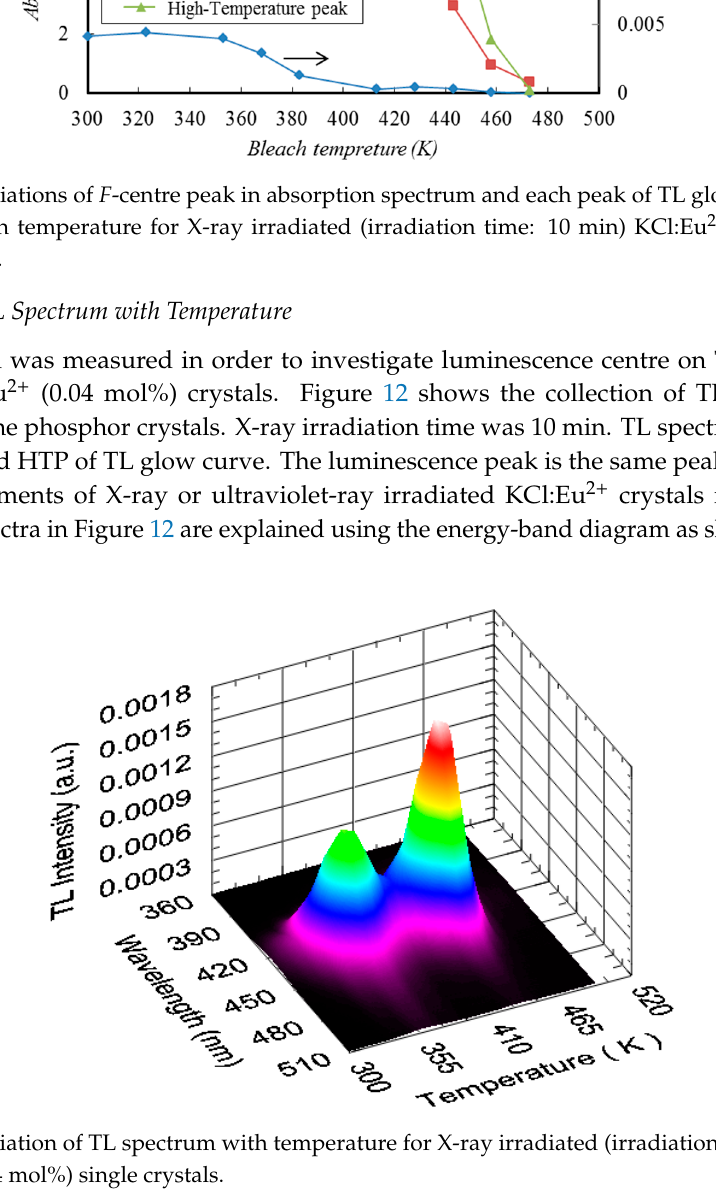
Figure 12. Variation of TL spectrum with temperature for X-ray irradiated (irradiation time: 10 min) KCl:Eu 2+ (0.04 mol%) single crystals.